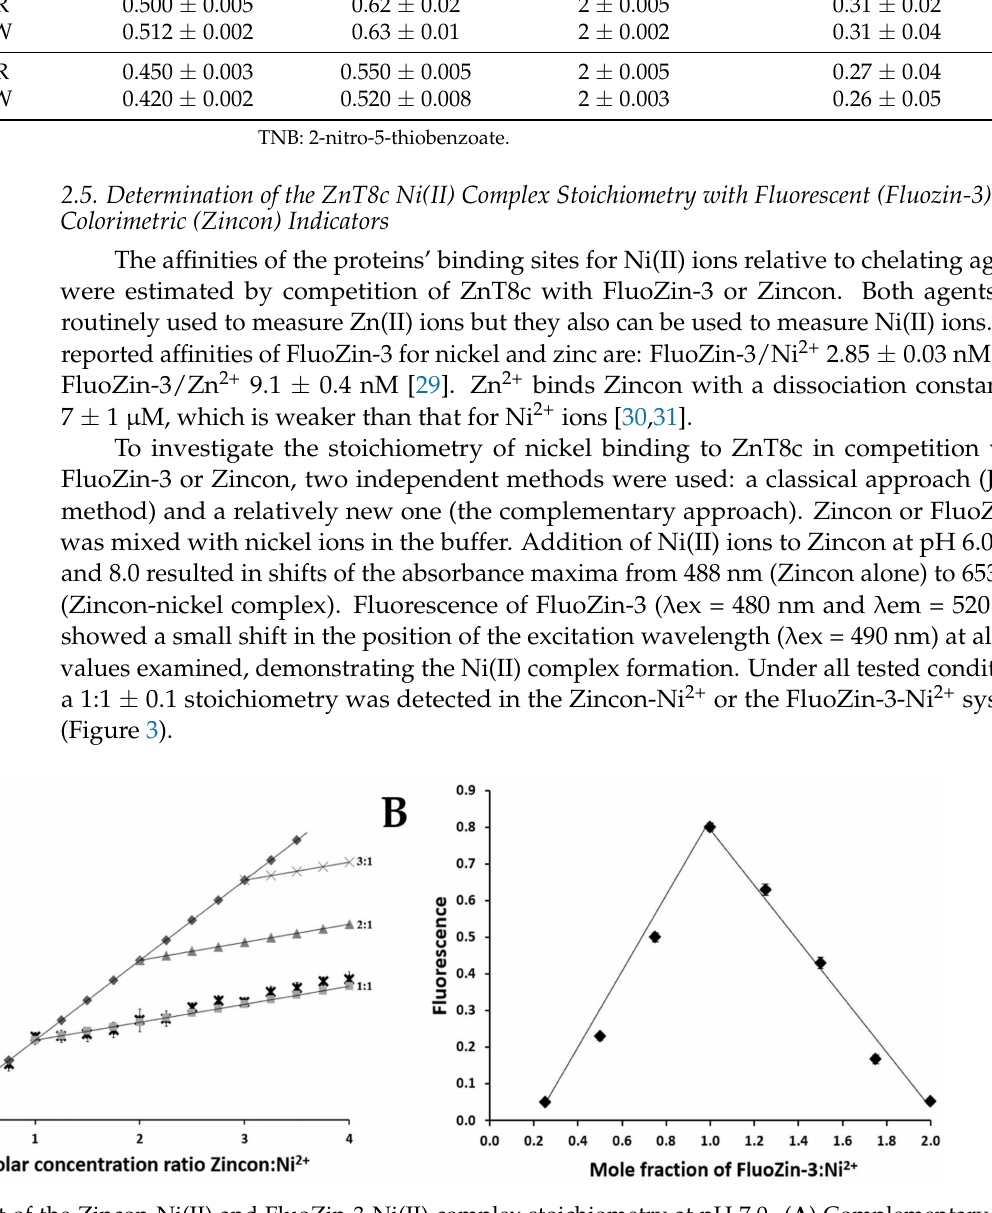
Figure 3. Assessment of the Zincon-Ni(II) and FluoZin-3-Ni(II) complex stoichiometry at pH 7.0. ( A ) Complementary Approach. The molar concentration of Ni(II) ions was kept constant at 25 µ M and the total molar concentration of Zincon was continuously varied from 6 to 100 µ M. The line with the grey diamonds corresponds to the absorbance of the complex formed after an excess of nickel was added. The other lines represent the theoretical absorbances expected if the stoichiometries were 1:1 (squares), 2:1 (triangles) or 3:1 (crosses). The comparison between the measured absorbance (black crosses) with the theoretical lines establishes a stoichiometry of 1:1. ( B ) Job’s method. The ratios refer to chelating agent/nickel. The total molar concentration of FluoZin-3 and Ni(II) was 100 µ M. The lines converge on a molar ratio of 1:1. The assessment was performed with three independent stock